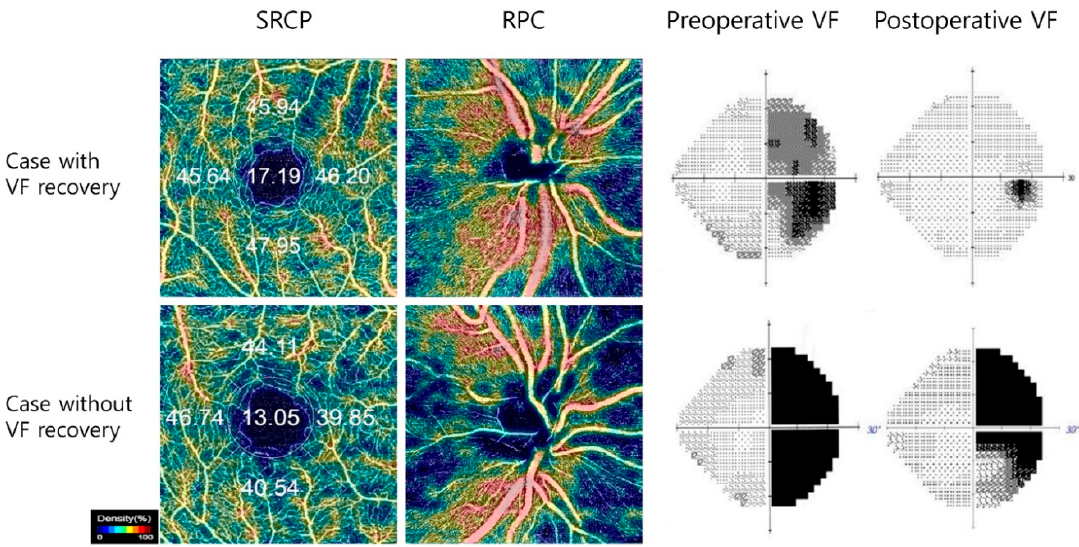
Figure 1. Two representative cases based on the degree of visual field (VF) recovery diagnosed with pituitary adenoma who underwent transsphenoidal tumor resection. In preoperative stage, OCT-A color-coded density maps showed in the superficial retinal capillary plexus (SRCP) and radial peripapillary capillary (RPC) segment. Preoperative vessel densities in the SRCP and RPC segment were correlated with postoperative VF recovery.